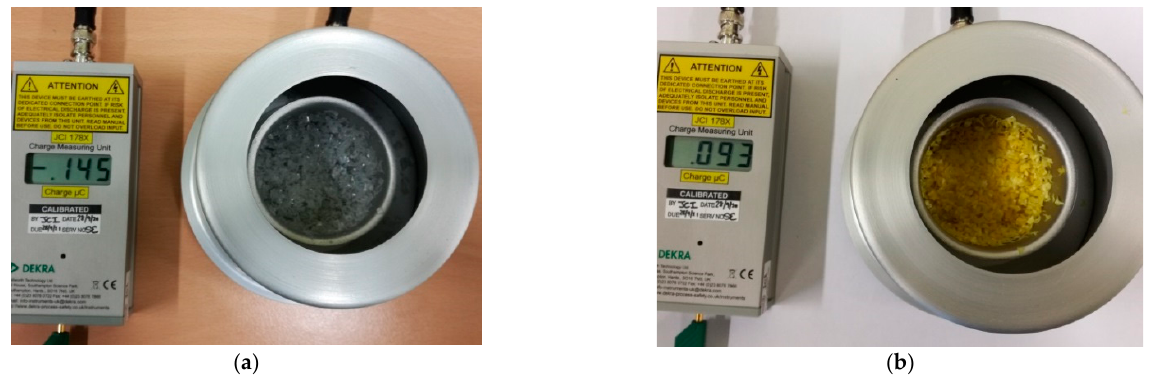
Figure 8. A system for measuring the accumulated charge on particles of ( a ) PET and ( b ) PE-HD polymers.